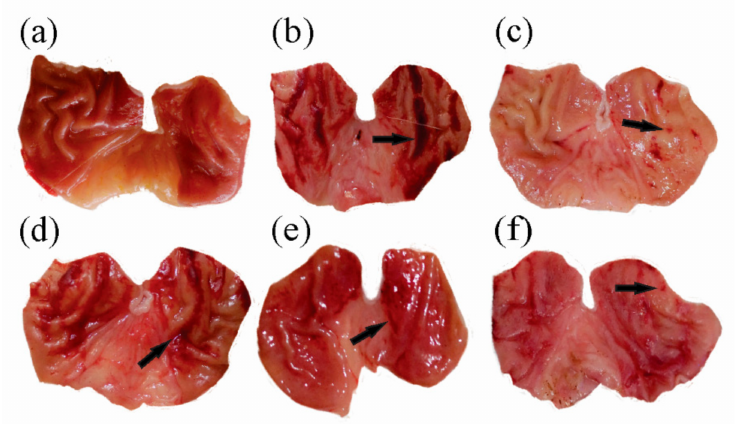
Figure 2. Representative images showing ethanol-induced gastric ulceration in rat’s stomach where arrowheads indicate macroscopic lesions and petechiae. ( a ) Normal control group showing nor- mal morphology, ( b ) intoxicated group showing widespread hemorrhagic lesions, ( c ) sucralfate (100 mg/kg) pre-treatment group showing few lesions and spot ulcers, ( d ) 30 mg/kg, ( e ) 100 mg/kg, and ( f ) 300 mg/kg Sf.Cr pre-treatment group showing dose-dependent gastroprotection.